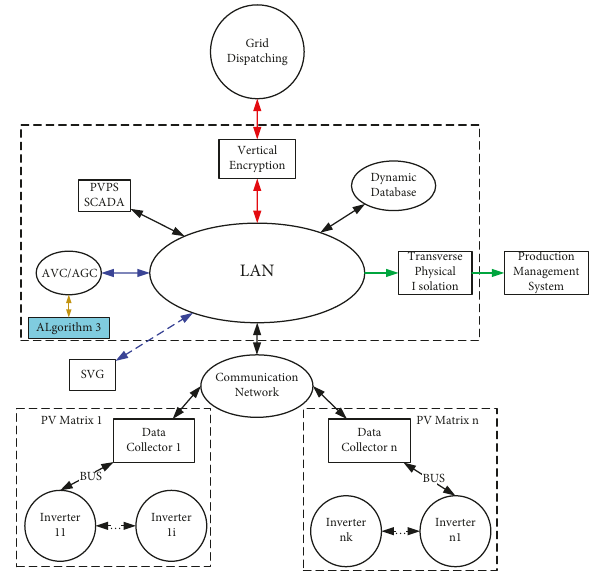
Figure 12: Schematic diagram of PVPS control